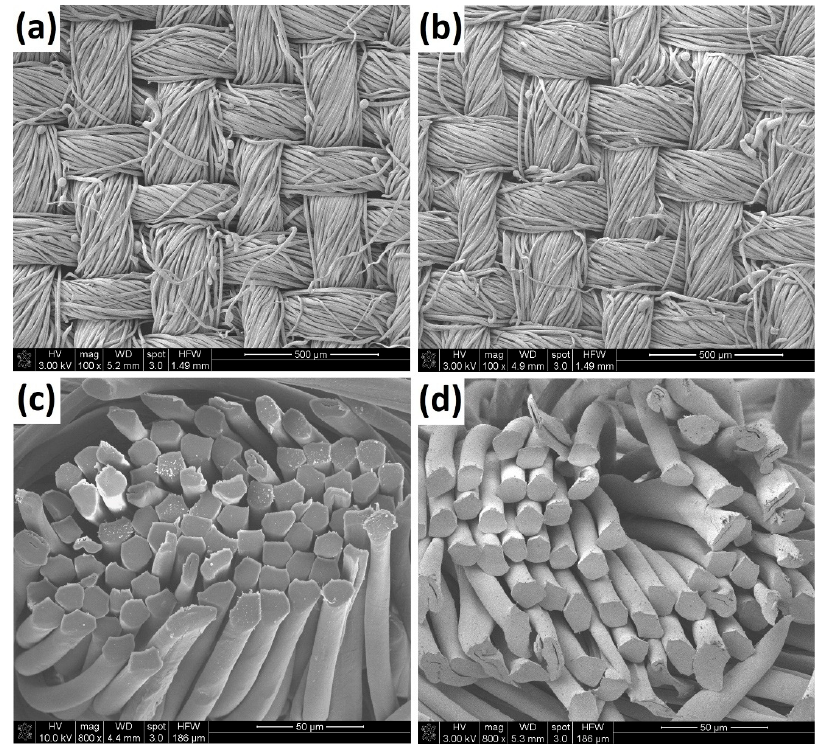
Figure 3. SEM images of Sample 3 (CO 75/PES 25): Woven fabric surface (magnification 100×) ( a ) before exposure and ( b ) after radiant heat exposure (10 kW·m − 2 , 40 s); cross-section of yarn (magni- ( a ) before exposure and ( b ) after radiant heat exposure (10 kW · m − 2 , 40 s); cross-section of yarn fication 800×) ( c ) before exposure and ( d ) after radiant heat exposure (10 kW·m − 2 , 40 s). (magnification 800 × ) ( c ) before exposure and ( d ) after radiant heat exposure (10 kW · m − 2 , 40